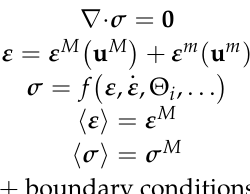
/ C m ; ( b ) C M / C m . 1111 1122 1111 1122